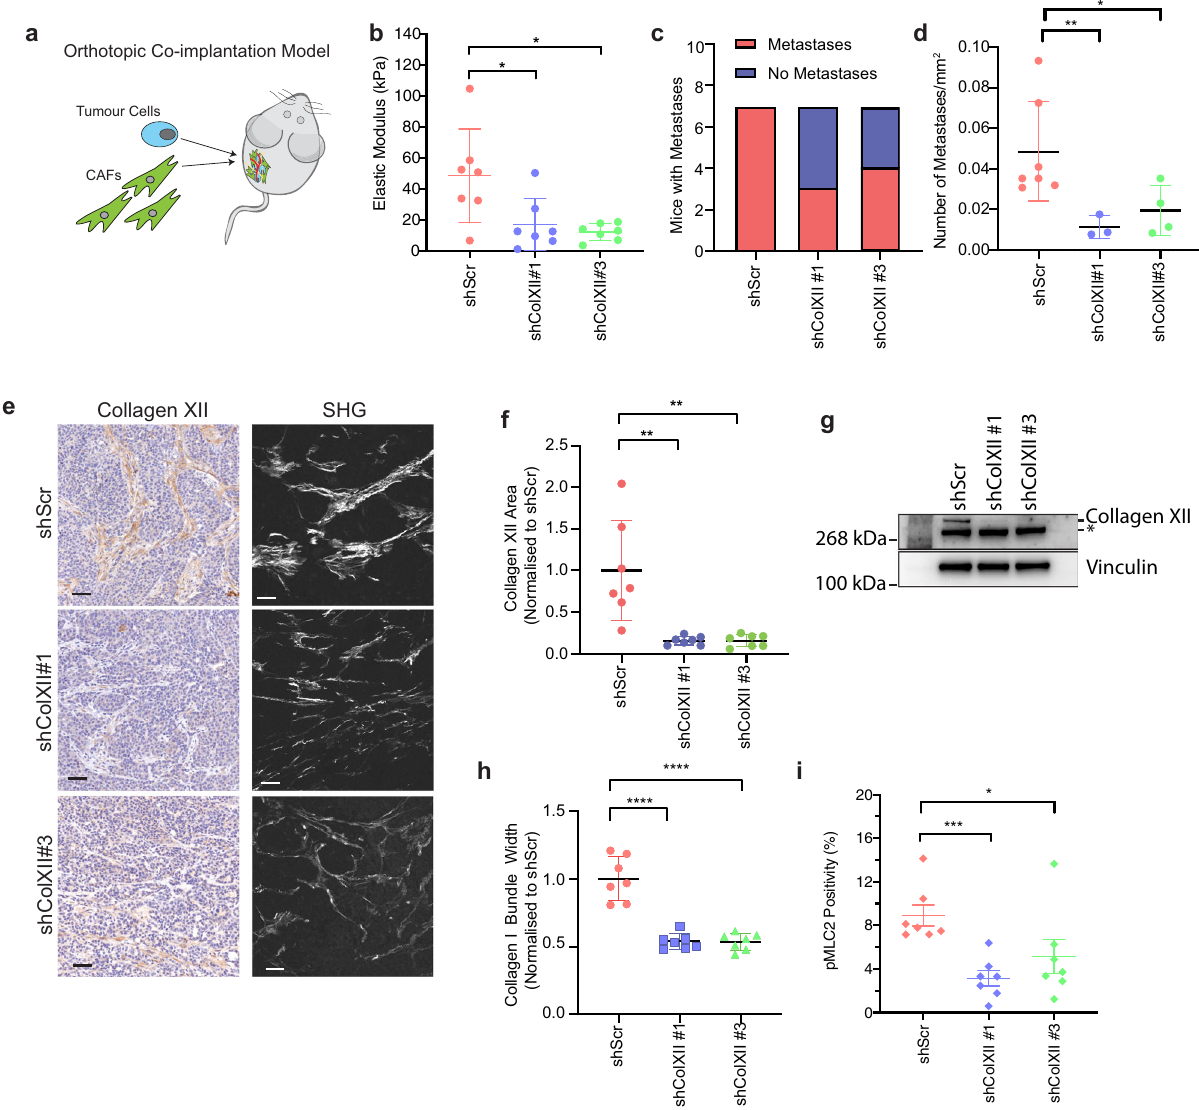
Fig. 8 | Collagen XII knockdown reduces metastasis in vivo. a Schematic representationoforthotopicco-implantationofcancercellsandCAFs(knockdown study:shScrandshColXII;overexpressionstudyeGFP-VPRandColXII-VPR)injected in a 1:3 ratio respectively. b Bulk modulus as determined by uncon fi ned compres- sion analysis of excised primary tumours generated by co-implantation of cancer cells with control (shScr) and collagen XII knockdown (shColXII#1, shColXII#3) CAFs. Mean±SD, n =7 biologically independent samples, * p <0.05, shScr vs shColXII#1 p =0.036, shScr vs. shColXII#3 p =0.045; Kruskal – Wallis test with Dunn ’ s multiple comparisons test. c Quantitation of the number of mice with or without observed metastases in H&E sections in the knockdown study ( n =7 mice per group). d Quanti fi cation of the mean number of metastases normalised to the totallungareainmicewithmetastasespresentintheknockdownstudy( n =7shScr, n =4 shColXII#1 and n =3 shColXII#3 mice with metastases present). * p =0.0278, ** p =0.0062 two-sided t test with Welch ’ s correction. Data are presented as mean±SD. e Representative images of (left) collagen XII IHC (scale bar=50 µ m)